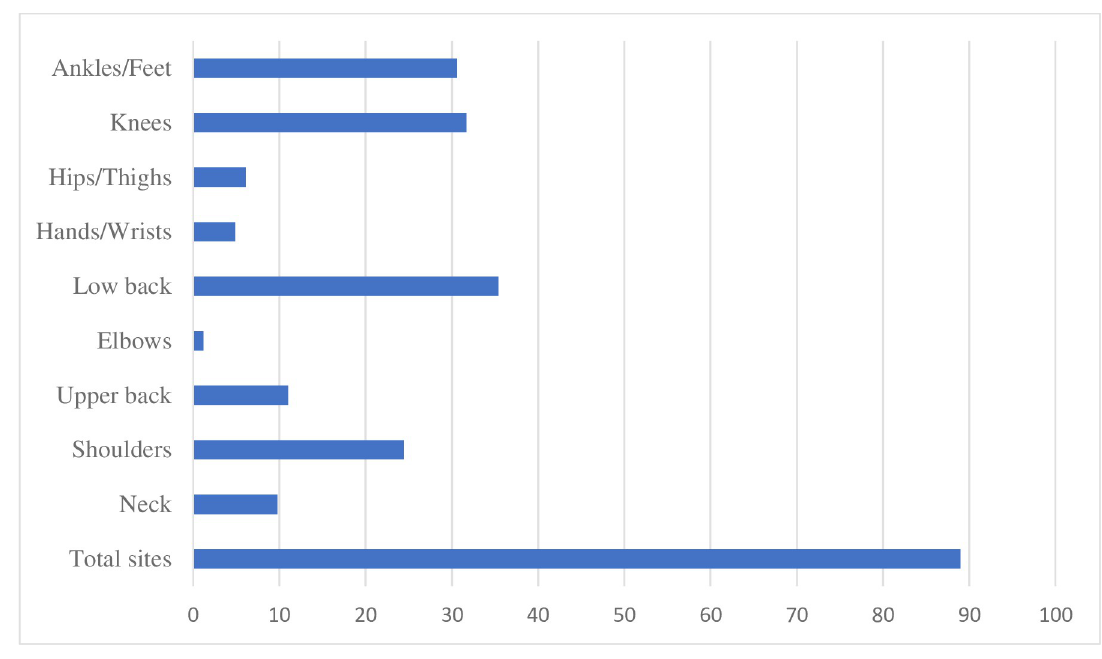
Fig 1. Location of MSD among housewives.